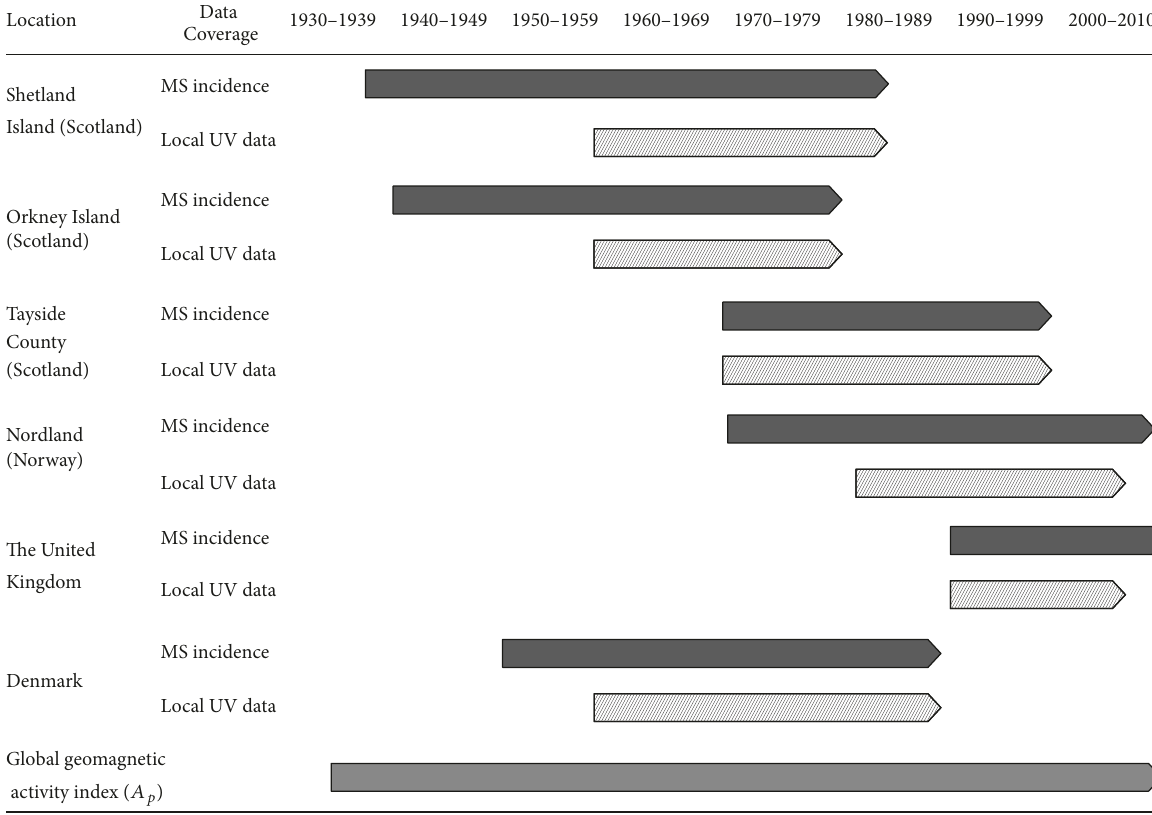
Figure 2: Data coverage of MS incidence, GMD, and received local